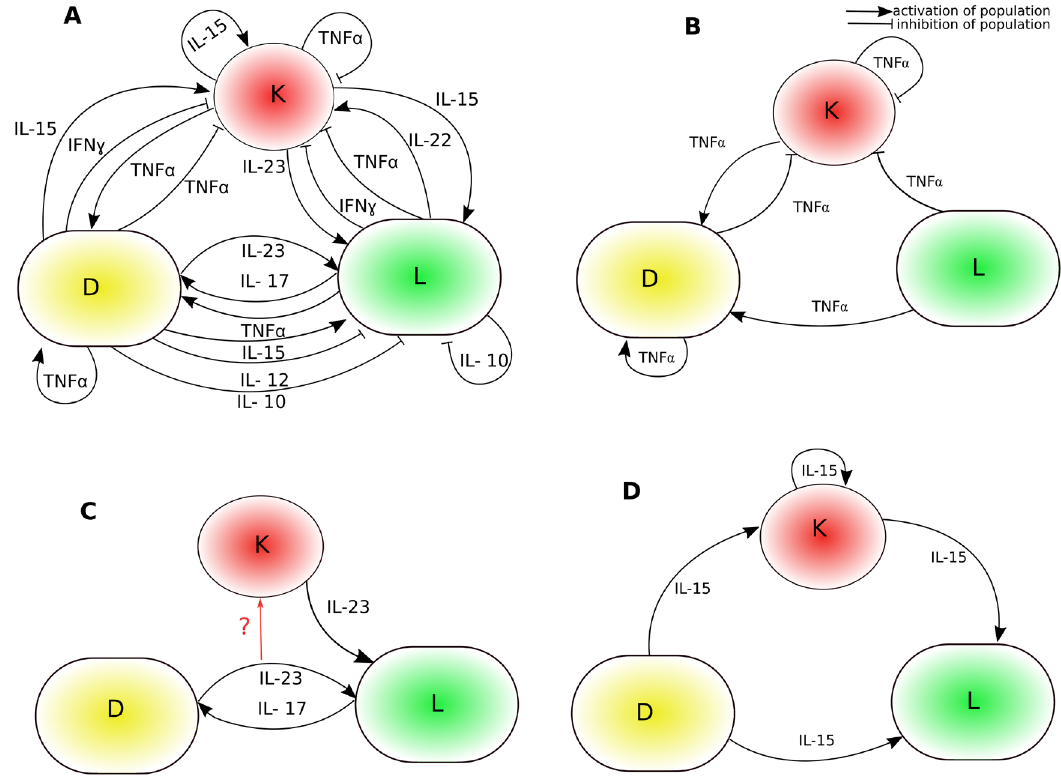
Figure 1. ( A ) A schematic diagram explaining cytokine mediated interactions among the cell types predominantly implicated in psoriasis. Here, L denotes the population of T-cells and for simplicity a single pool is considered. The symbol D represents matured dendritic cells(DCs). Note that the primary role of immature DCs is in antigen detection, uptake and processing whereas mature DCs are believed to function in antigen presentation and cytokine production 17 . The symbol K represents the population of keratinocytes. Arrows show an increase in population and lines with a bar end denote inhibition of the population. ( B ) A subnetwork of the network ( A ) involving only TNF α . ( C ) Cytokine IL-17 and IL-23 mediated subnetwork of the network. Here, a red colored arrow represents the net effect of the dendritic and T-cell population on keratinocytes. The question mark indicates the lack of clarity about this signal which could be either inducing or inhibiting. ( D ) The subnetwork involving cytokine IL-15